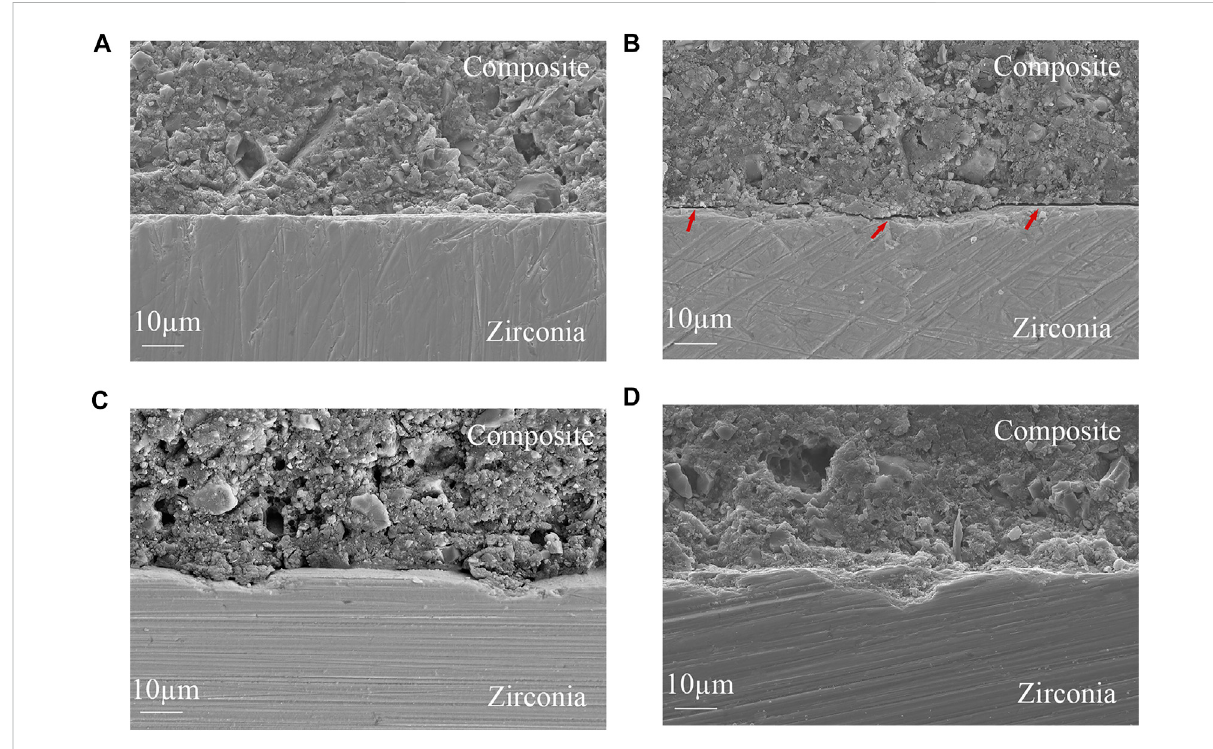
FIGURE 5 Zirconia/resincementinterfacialSEMimages(×1,000magni fi cations) (A) notreatment (B) sandblasting (C) hotetching withHCl (D) hotetching with HF (Interfacial cracks are visible at the red